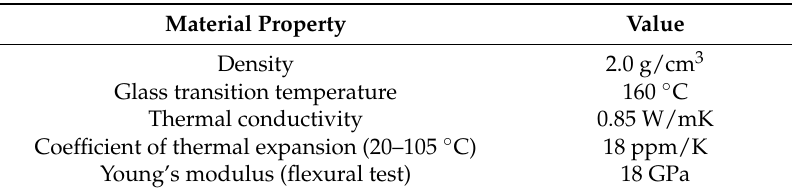
Table 2. Key properties of material NU6110V according to Ref. [15].